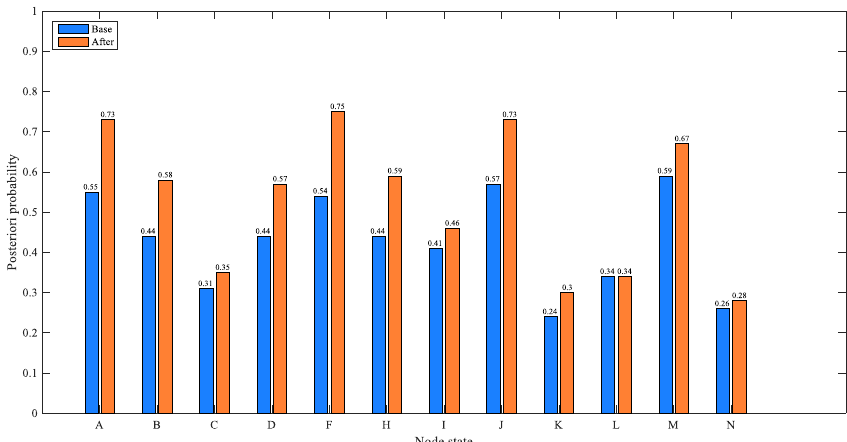
Figure 8. Comparison of the probability of other nodes before and after the states of “safety management system” and “safety education and training” change.